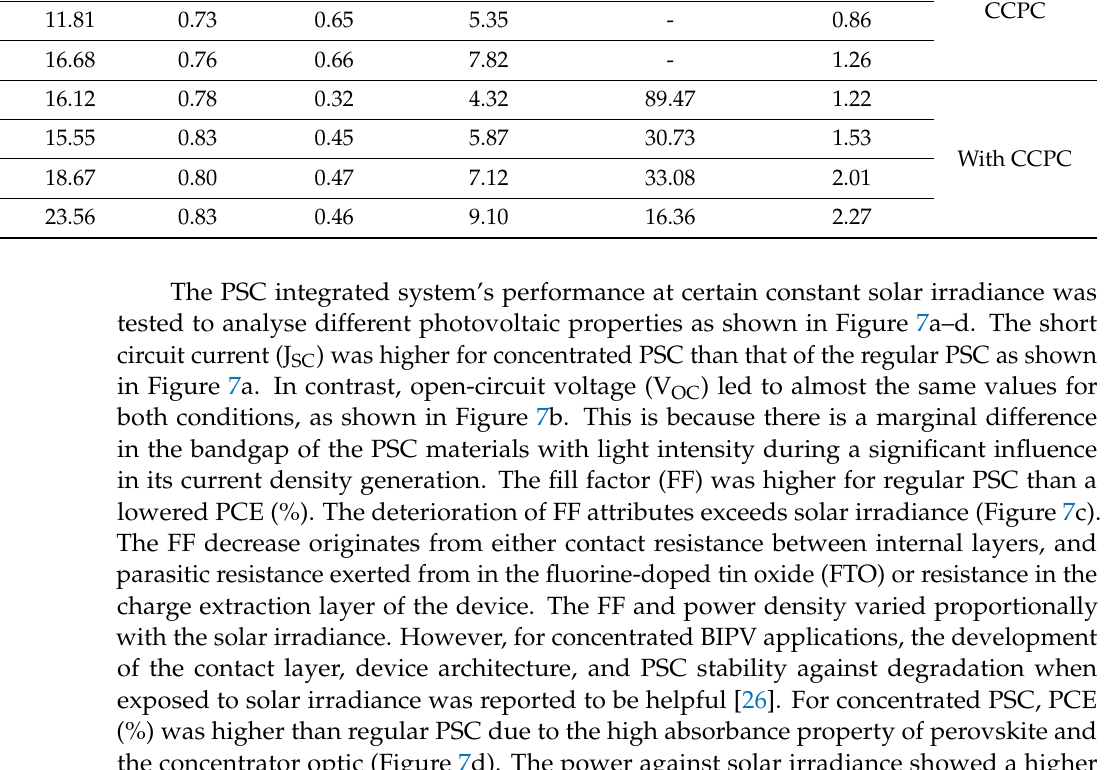
Figure 6. A plot of photovoltaic parameters variation such as ( a , c ) current-density vs circuit voltage (forward scan), and ( b , d ) power vs open-circuit voltage under different solar irradiance for the PSC and CCPC-integrated-PSC devices.